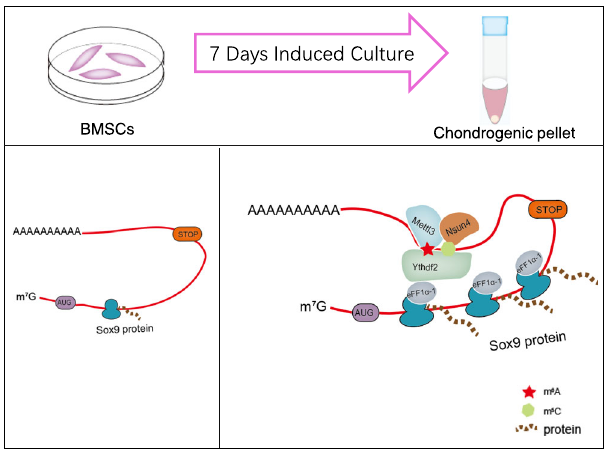
Fig. 7 Schematic diagram showing the mechanism of the translation reprogramming of Sox9. During chondrogenic differentiation of BMSCs, Nsun4 and Mettl3 co-methylated Sox9 by targeting on its 3 ’ UTR region. Nsun4 and Mettl3 was assembled with recruitment of Ythdf2 and eEF1a-1. Eventually, the NMYE complex, carrying the methylated Sox9 mRNA, bound to ribosome, and then Sox9 mRNA was delivered to the ribosome for